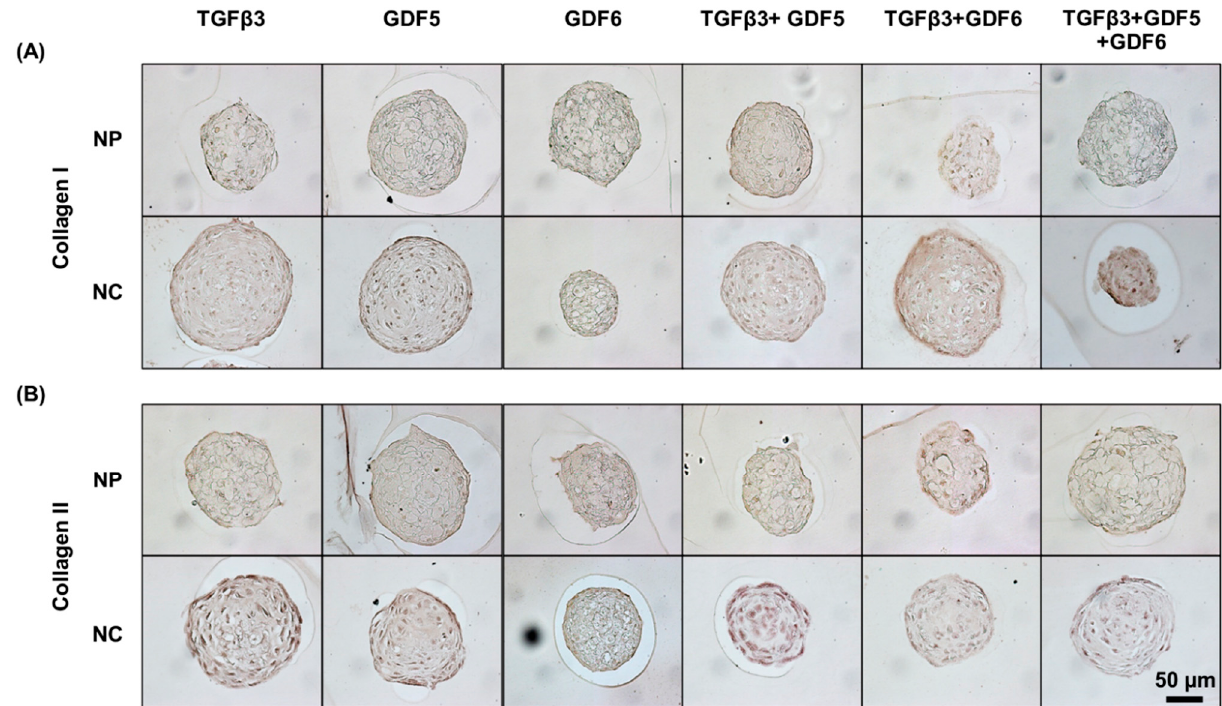
Figure 7. Immunostaining for collagen types I and II of nucleus pulposus (NP) and nasoseptal chondrocyte (NC) microtissues stimulated with TGF β 3, GDF5, GDF6, TGF β 3 + GDF5, TGF β 3 + GDF6, TGF β 3 + GDF5 + GDF6 on day 7. ( A ) Collagen type I and ( B ) Collagen type II.